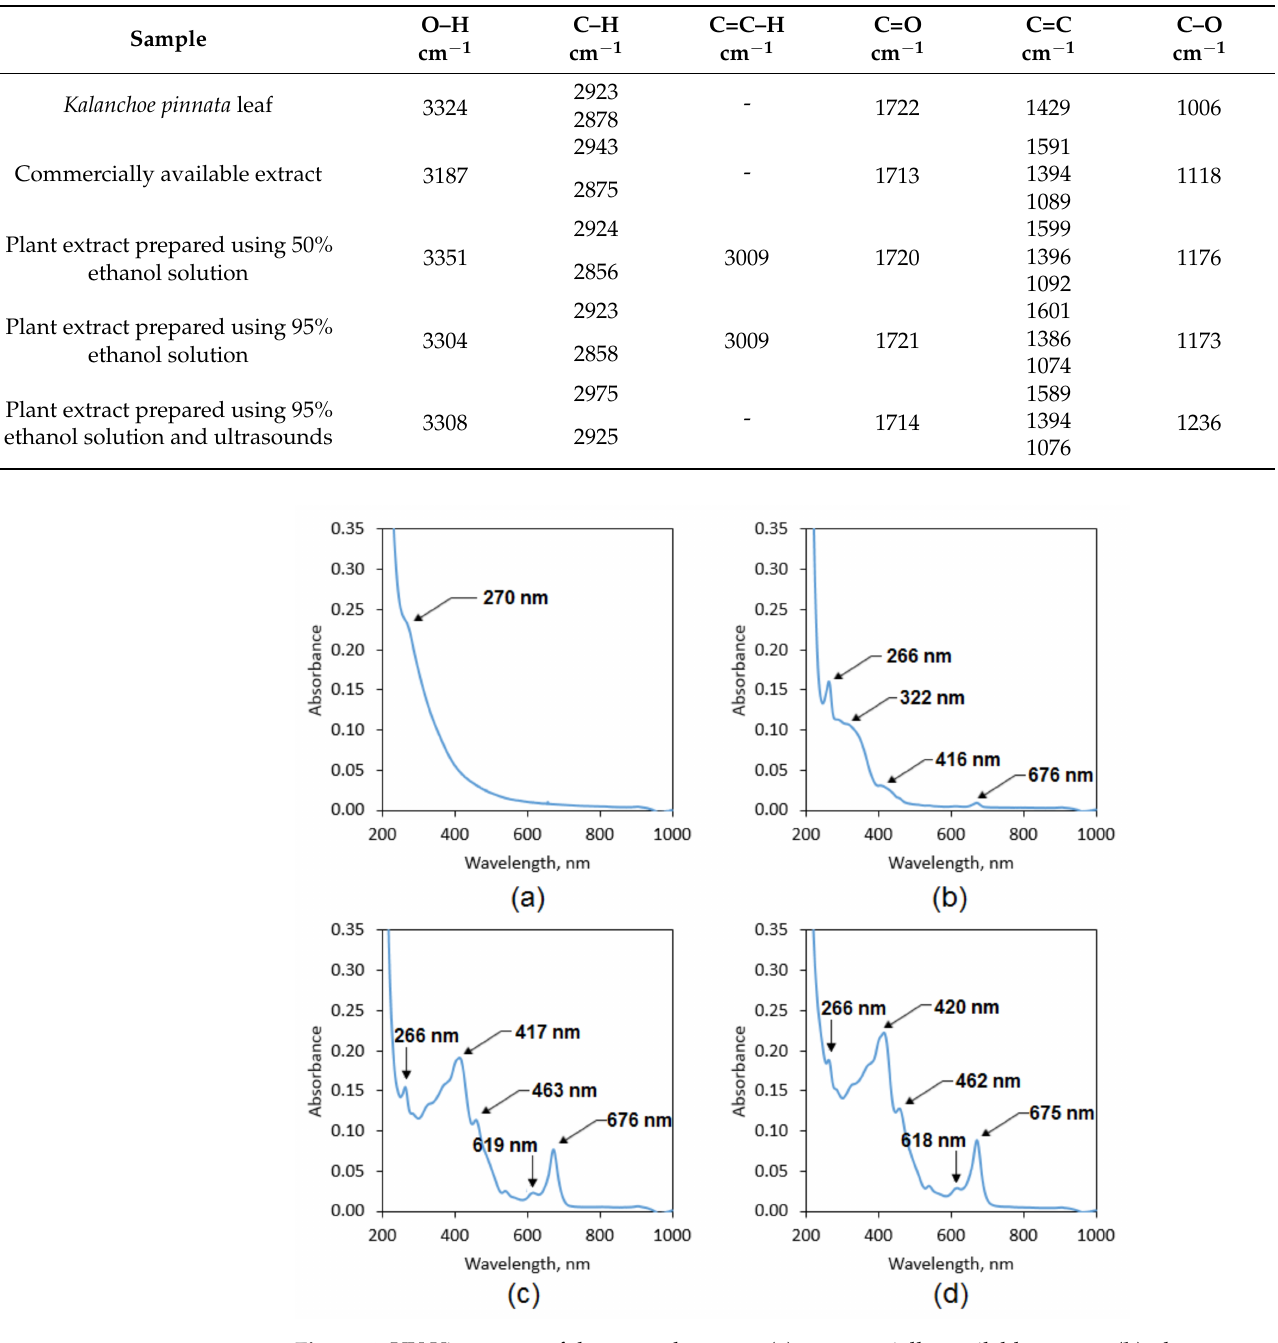
Table 2. Fourier transform infrared spectroscopy (FTIR) analysis results.